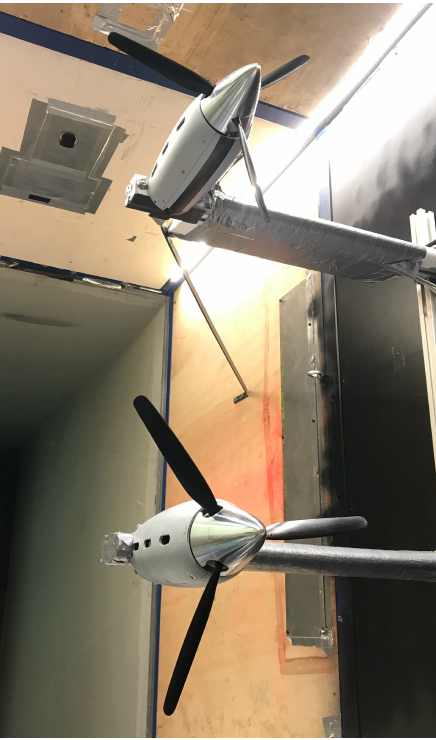
Figure 4. Layout of the side-by-side propeller models test rig at S. De Ponte wind